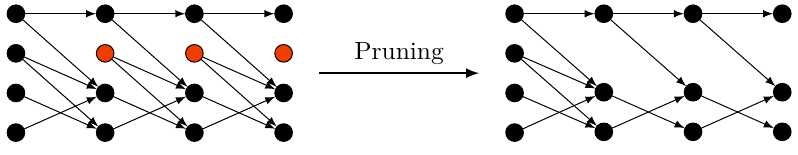
Figure 2: Left: A graph representing parts of linear/differential trails over three rounds of a cipher. Right: The graph after all edges and vertices which are not part of a full trail have been